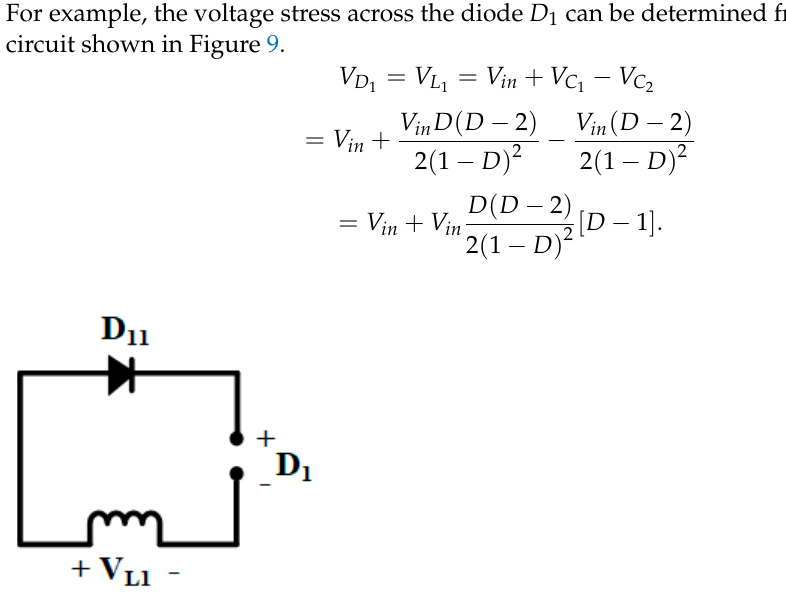
Figure 9 . HG-SIQBC—equivalent circuit to find the voltage stress across diode D 1 .